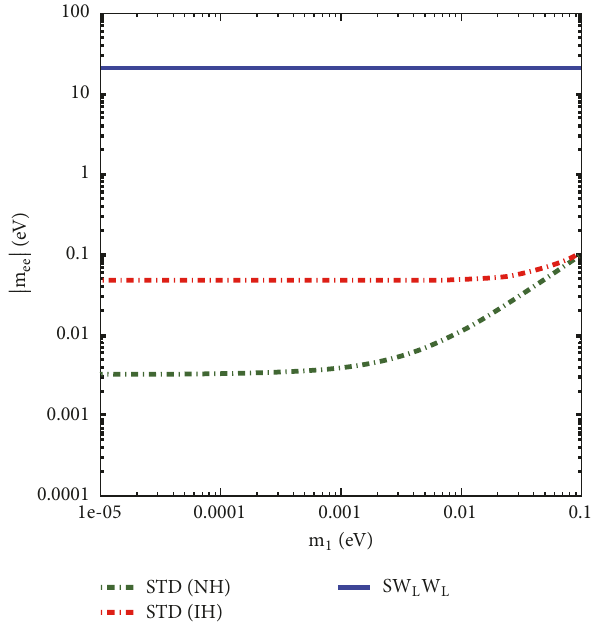
sterile neutrino mass. The sterile neutrino exchange contri- bution completely dominates over light neutrino exchange = 1.3 − 7 GeV in case of IH but for contributions for 𝑚 푆 1 = 1.5−20 GeV in case of NH. At 𝑚 ≃ 1.5𝐺𝑒𝑉 both 𝑚 푆 1 푆 1